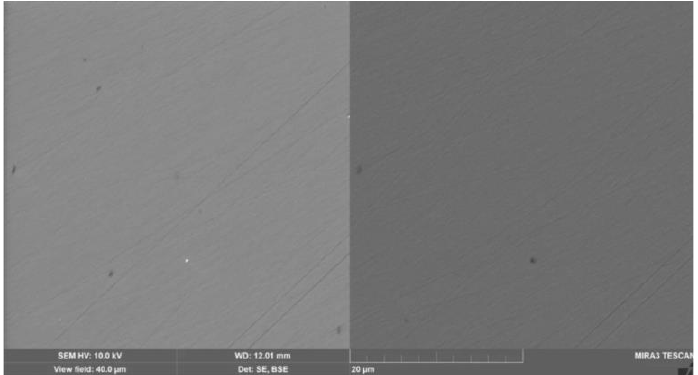
Figure 8. The morphology of the deposited interference coating determined by Tescan MIRA 3 LMU.